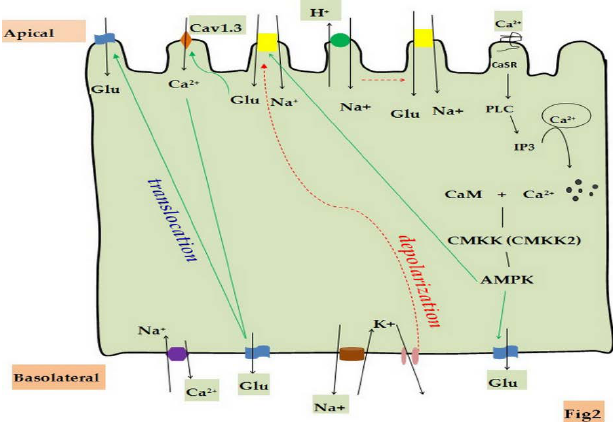
Figure 2. Schematic illustration of regulatory mechanisms of small intestinal glucose uptake by cation channels and transporters. Glucose absorption takes place in small intestinal villus cells by SGLT1, which is driven by active sodium extrusion via the basolateral Na + /K + ATPase. When basolateral K + channels are closed to depolarize the membrane voltage, the electrogenic transportation of glucose is blocked. Intestinal glucose absorption is also up-regulated by Ca 2+ -dependent apical GLUT2 insertion. The [Ca 2+ ] cyt is mainly excluded by NCX1 on the basolateral IEC. NHE3 suppresses SGLT1 and ultimately affects intestinal glucose absorption. Increased [Ca 2+ ] cyt through CaSR is combined with CaM as a complex, which modulates AMPK and further activates SGLT1 or GLUT2 to adjust small intestinal glucose